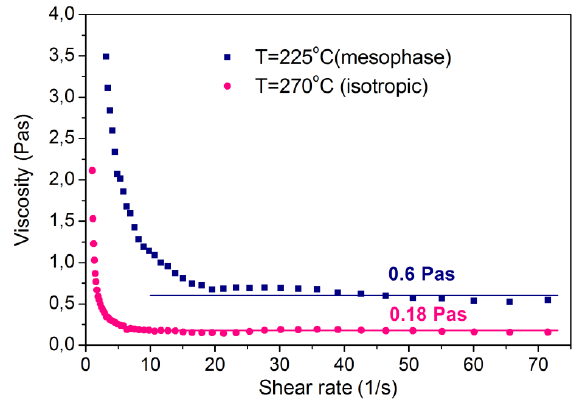
Figure 10. Dynamic viscosity of 10-BPhCOOH for the mesophase (@ 225 °C) and the isotropic state (@ 270 °C).